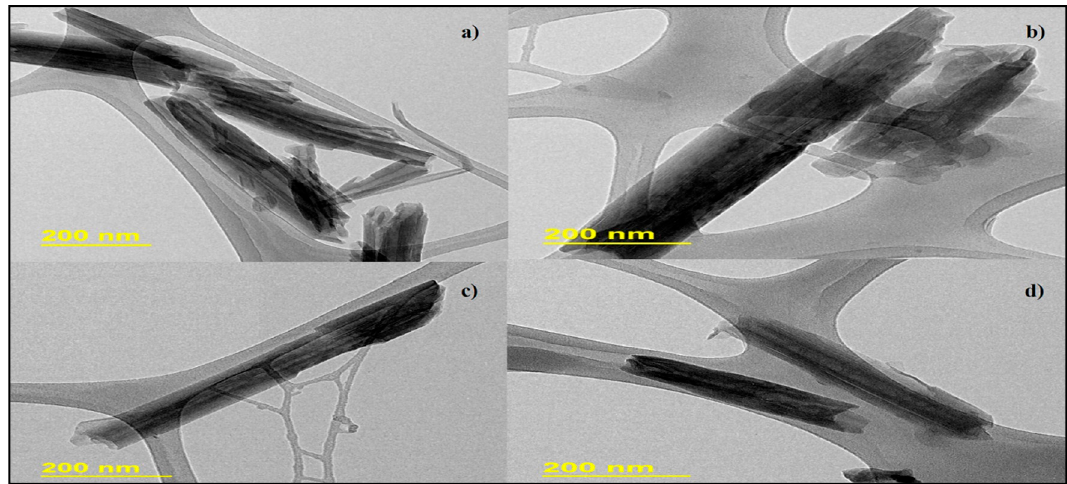
Figure 1. TEM images ( a , b ) of pristine Halloysite nanotubes (HNTs); ( c , d ) of Chlorhexidine-loaded Halloysite nanotubes (HNT/CHX). Halloysite nanotubes (HNT /